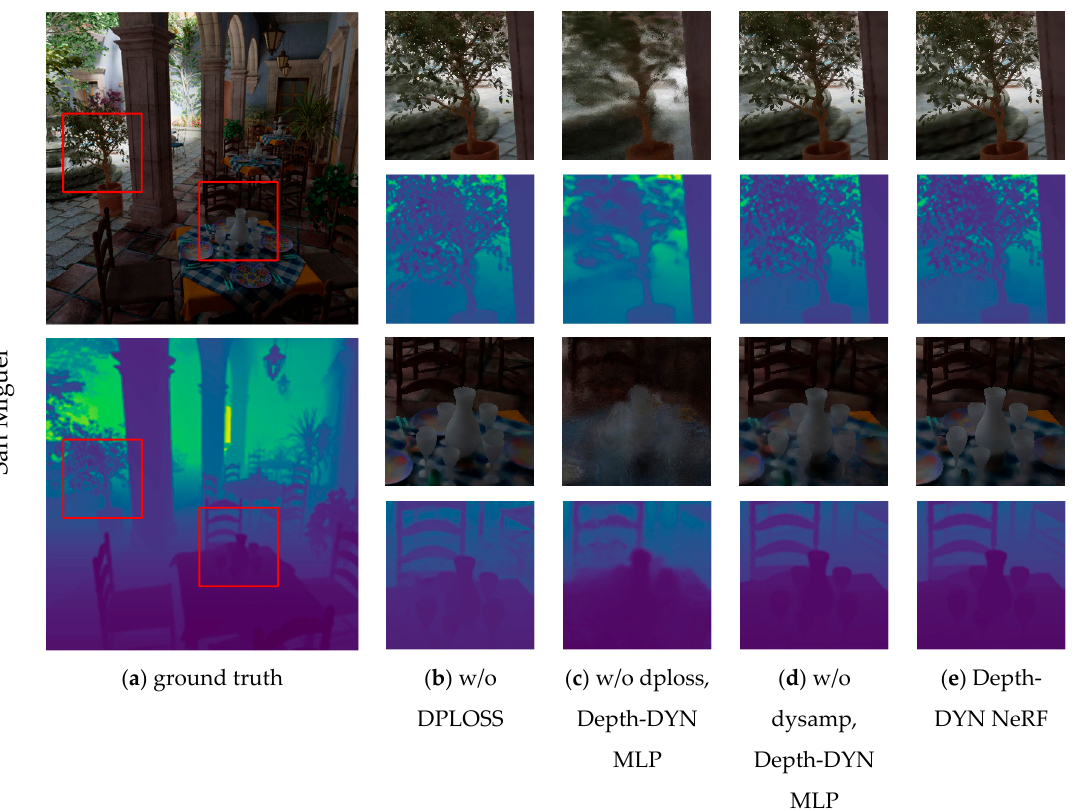
Figure A1. The rendered image of the Classroom scene and the depth of the test scene are com- pared with the real image and depth.